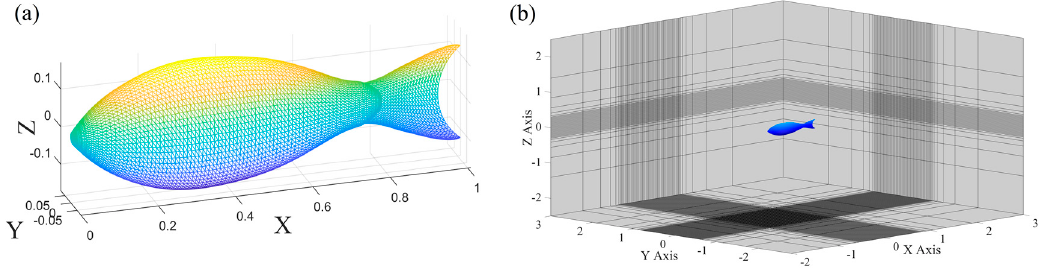
Figure 3. ( a ) Integrated fish model mesh with both the trunk and tail. ( b ) Nonuniform Cartesian mesh in the computational domain. Only one out of every five points in each direction is shown.